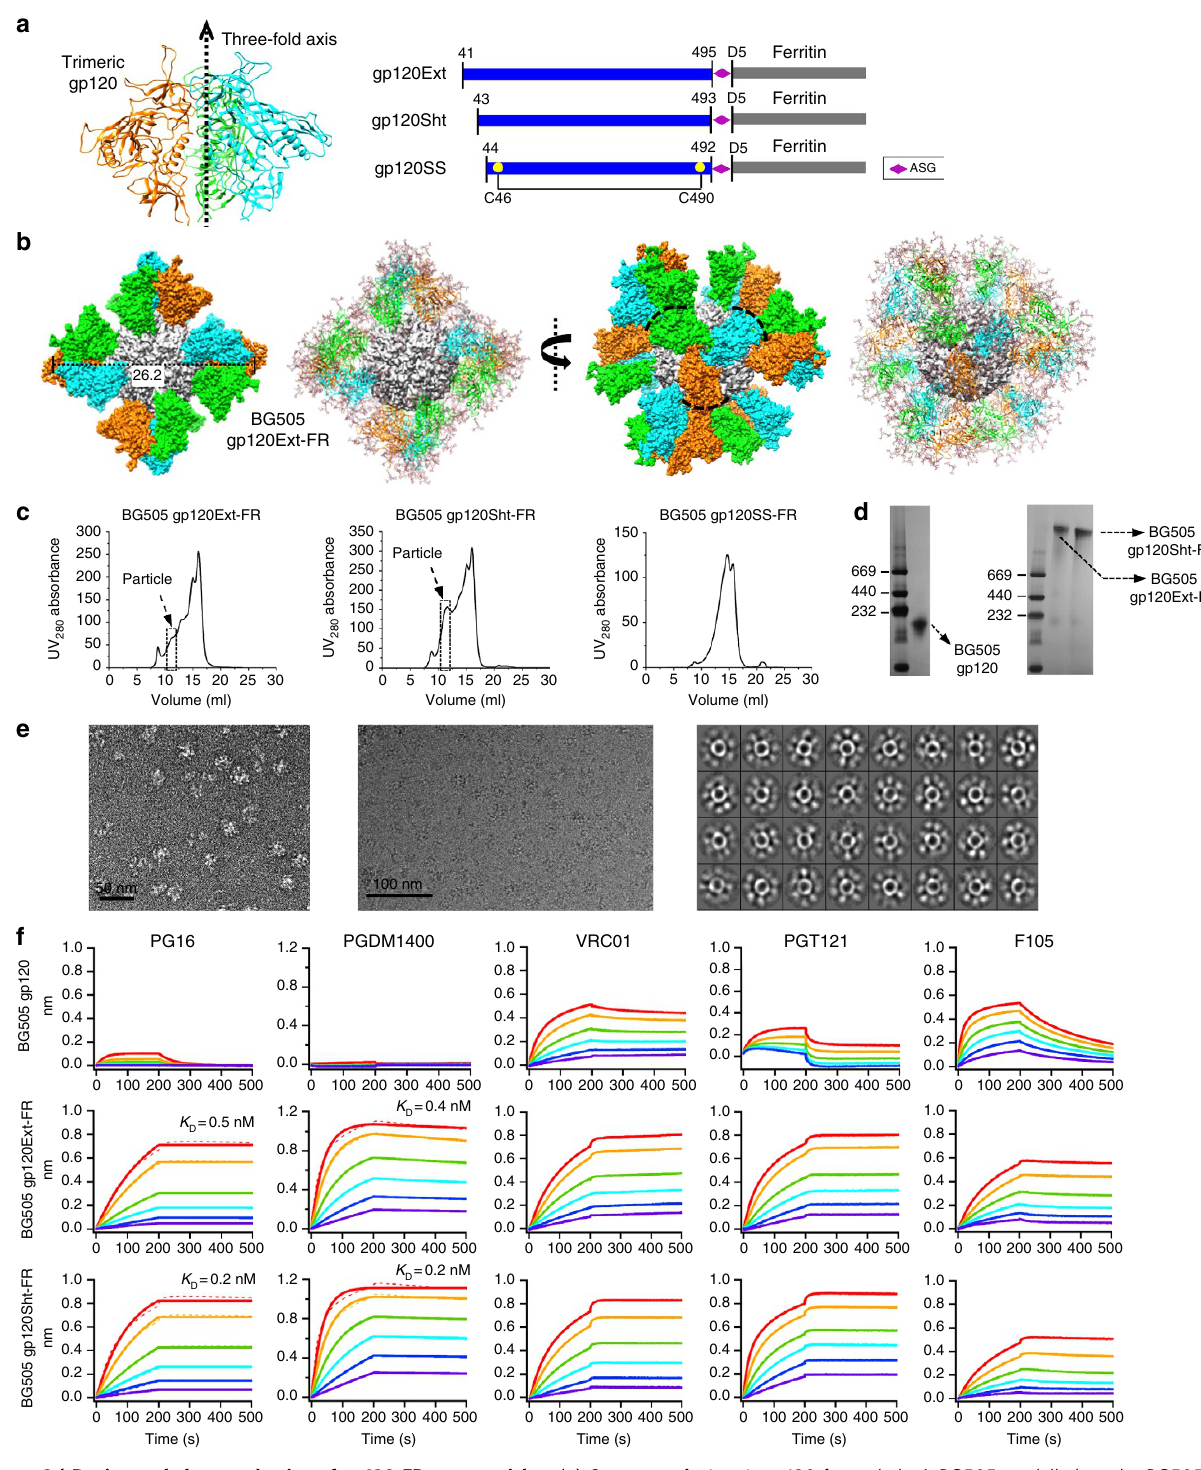
Figure 2 | Design and characterization of gp120-FR nanoparticles. ( a ) Structure of trimeric gp120 from clade-A BG505 modelled on the BG505 SOSIP.664 trimer (PDB ID: 4TVP) (left) and schematic representations of gp120Ext-, gp120Sht- and gp120SS-FR (FR) constructs (right). Three gp120 chains are coloured in cyan, green and orange, respectively. ( b ) Structural models of the gp120Ext-FR nanoparticle rotated by 90 (cid:2) . For each view, the surface model of protein particle is shown on the left, whereas the ribbon model of trimeric gp120 spikes decorated with N -linked glycans is shown on the right. FR and three gp120 chains within each trimeric spike are coloured in grey, cyan, green and orange, respectively. ( c ) SEC profiles of gp120Ext-FR (left), gp120Sht-FR (middle) and gp120SS-FR (right) from a Superose 6 10/300 GL column. Fractions used for EM and antigenic analyses (10.5–11.25ml) are indicated with a dashed box. ( d ) BN-PAGE of monomeric gp120 and two gp120-FR nanoparticles. ( e ) EM analysis of gp120Sht-FR: micrograph derived from negative-stain EM (left), micrograph (middle) and 2D class averages (right) derived from cryo-EM. ( f ) Octet binding of monomeric gp120 and two gp120-FR nanoparticles to a panel of bNAbs and non-NAbs, with additional antibody binding data shown in Supplementary Fig. 2. Sensorgrams were obtained from an Octet RED96 instrument using a titration series of six starting at the maximum of 200nM for monomeric gp120 and 50nM for gp120 nanoparticles, respectively. K D values are calculated from 1:1 global fitting for apex-directed bNAbs PG16 and PGDM1400. NATURE COMMUNICATIONS|7:12041|DOI: